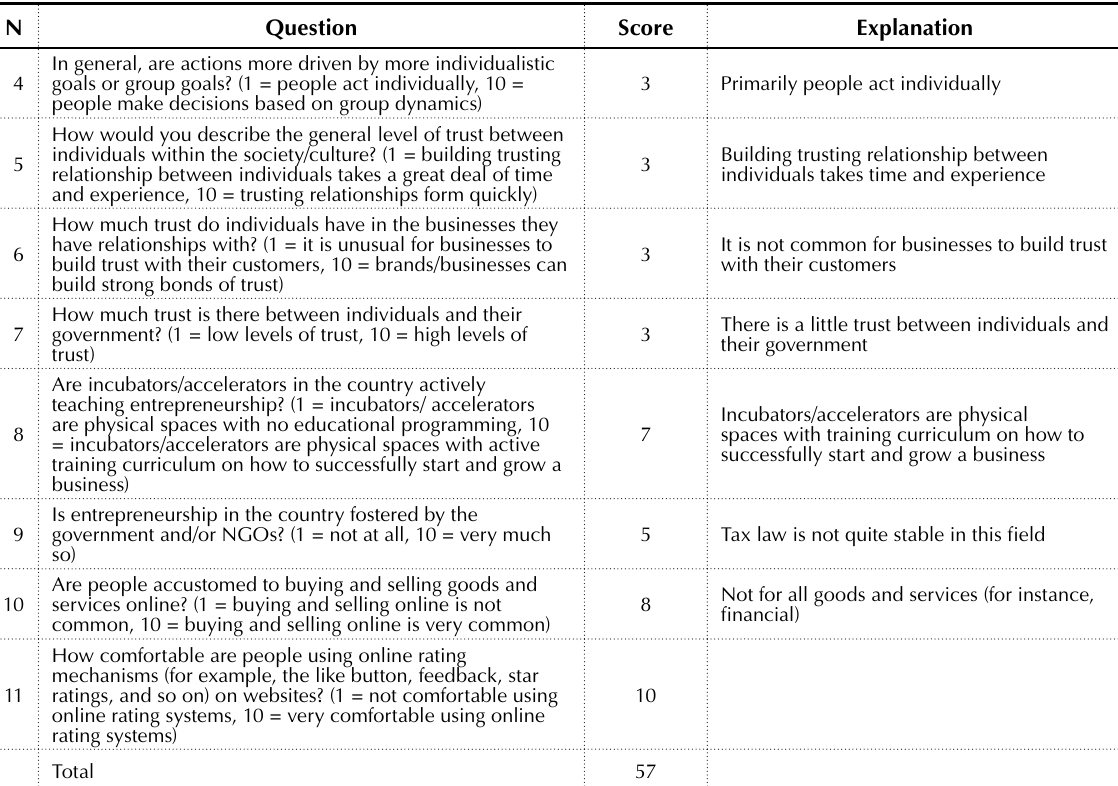
Table 4 (cont.). Assessing a country’s readiness for crowdfunding: culture